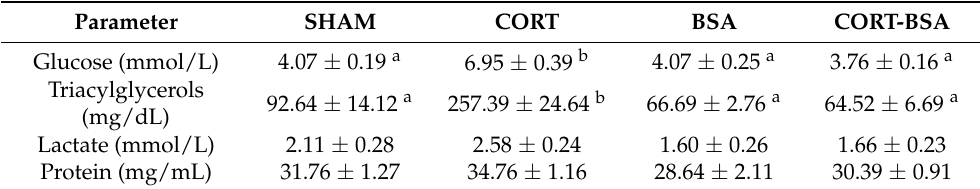
Table 1. Plasma glucose, triacylglycerols, lactate and proteins levels in vehicle (sham-control), cortisol, BSA and cortisol-BSA administered fish at 72 h post-treatment. Results are expressed as mean ± SEM ( n = 8). Different letters indicate significant differences between groups ( p value < 0.05). All data were analyzed using one-way ANOVA and Tukey’s HSD as a post-hoc test. Parameter